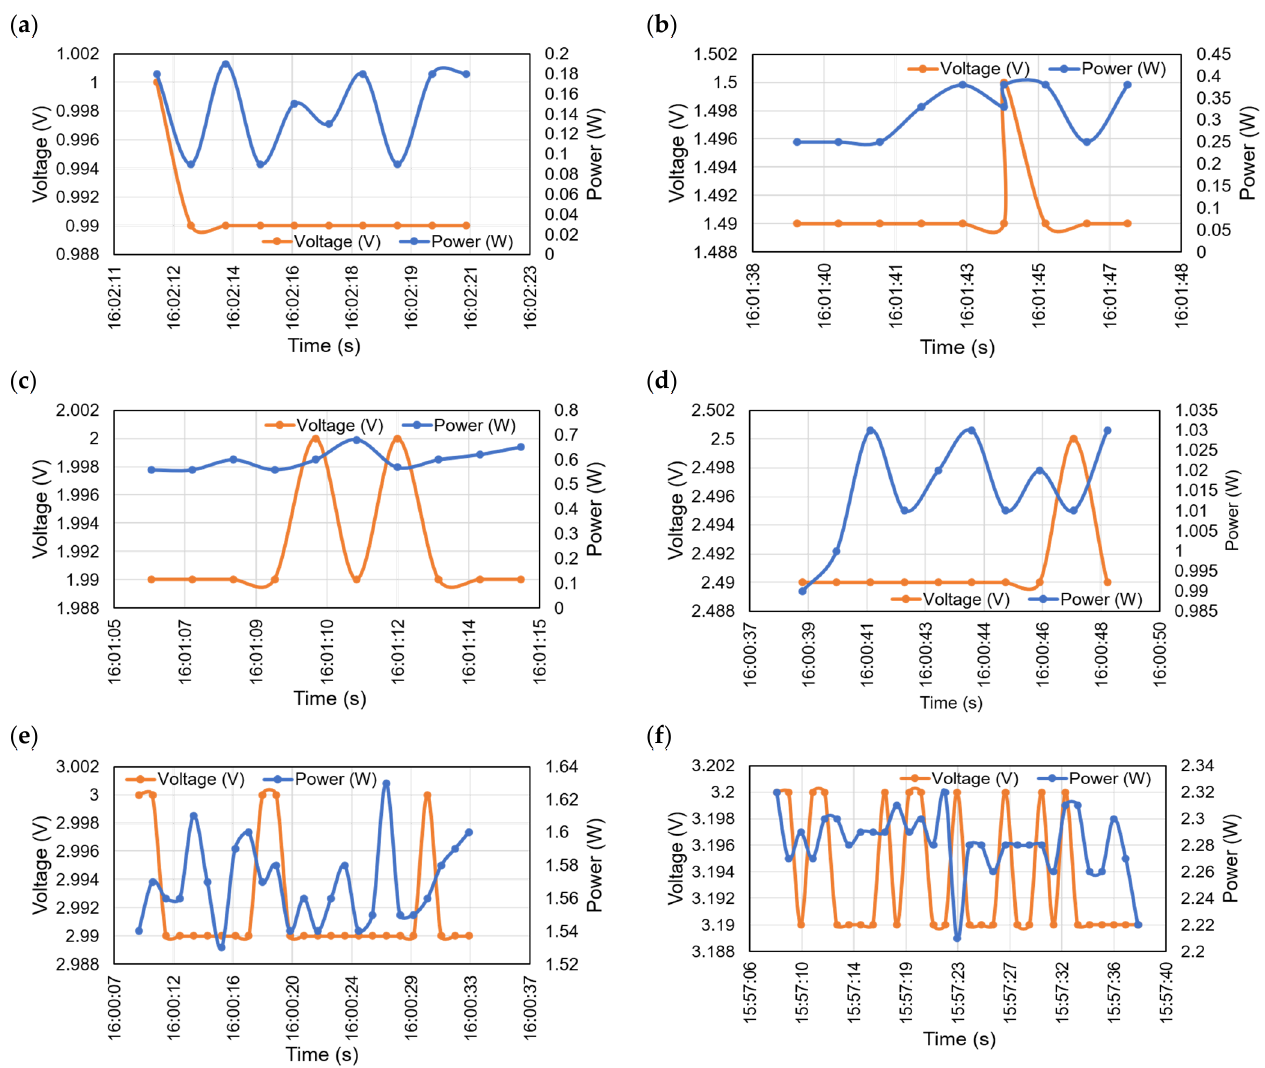
Figure 9. Generated voltage and power from the proposed system at different illumination level and time; ( a ) voltage and power vs. time at 40 lux; ( b ) voltage and power vs. time at 60 lux; ( c ) voltage and power vs. time at 80 lux; ( d ) voltage and power vs. time at 100 lux; ( e ) voltage and power vs. time at 120 lux; ( f ) voltage and power vs. time at 130 lux. Table 2. Measurements of the generated power (P GEN ) and consumed power.